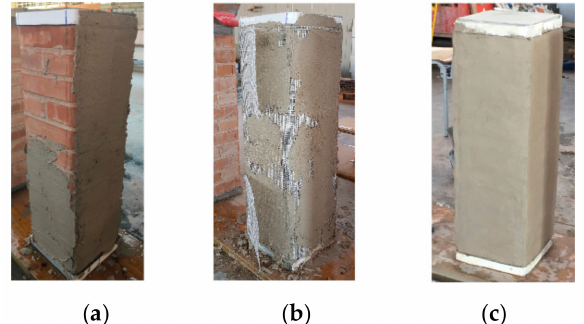
Figure 5. Confinement steps: ( a ) application of the first mortar layer, ( b ) sheet / fabric mesh installation and ( c ) application of the external mortar layer.